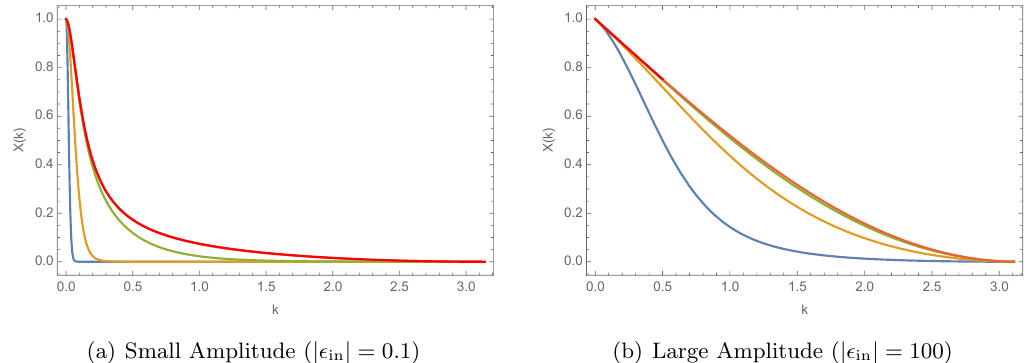
Figure 12 . Momentum mode contribution to the expectation value as a function of the amplitude and the quench rate. Di(cid:11)erent curves correspond to di(cid:11)erent quench rates: J(cid:14)t = 100 is blue; J(cid:14)t = 10 is yellow; J(cid:14)t = 1 is green; and J(cid:14)t = 0 : 1 overlaps in both (cid:12)gures with the red curve that corresponds to the instantaneous answer (B.3). The di(cid:11)erent rate of decay in each (cid:12)gure is clear, showing that only small momenta contribute in the small amplitude case while high modes start contributing for large